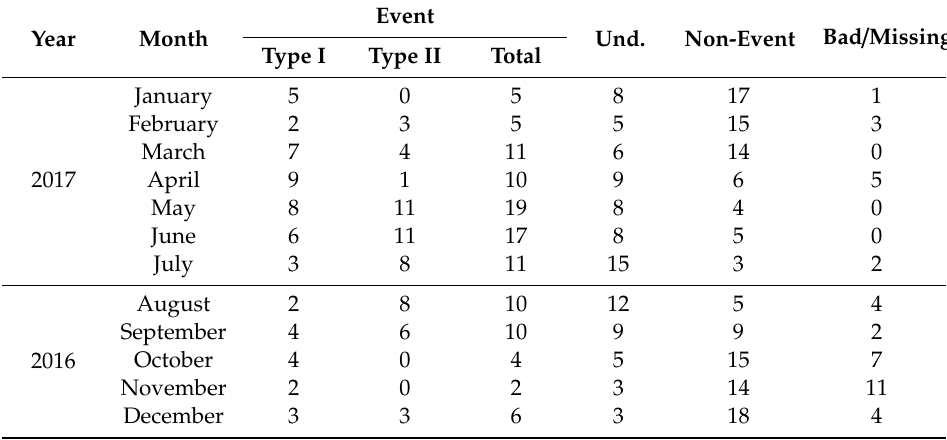
Table 1. New particle formation events, non-event, undetermined, and bad / missing data. Event Year Month Und. Non-Event Bad / Missing Type